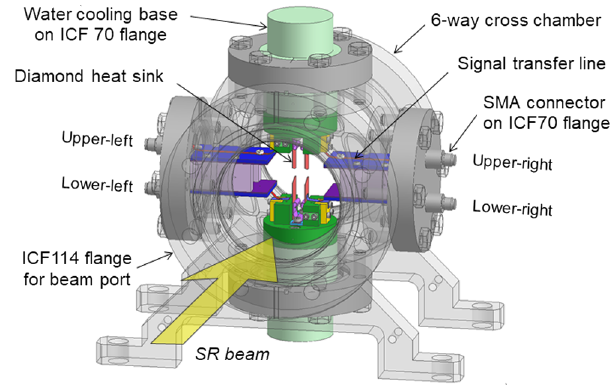
FIG. 1. Diamond heat sink (upper right) and configuration of transmission lines having microstripline structure and heat sinks mounted on a cooling base. In this figure, two lower heat sinks (LL, LR) out of four heat sinks and signal transmission lines for the two left-sided heat sinks (UL, LL) are shown.